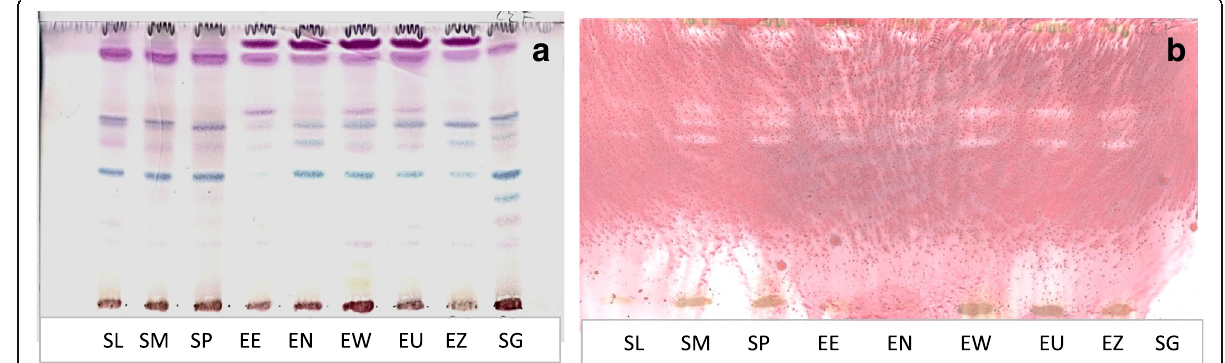
Fig. 1 a Chromatogram developed in chloroform: ethyl acetate: formic acid (CEF) solvent system of the acetone leaf extracts of the nine plants sprayed with vanillin. b Bioautography of Escherichia coli developed with CEF; white bands indicate compounds that inhibit the growth of the bacteria. SL = Syzygium legatii , SM = Syzygium masukuense , SP = Syzygium species A, SG = Syzygium gerrardii , ER = Eugenia erythrophylla , EN